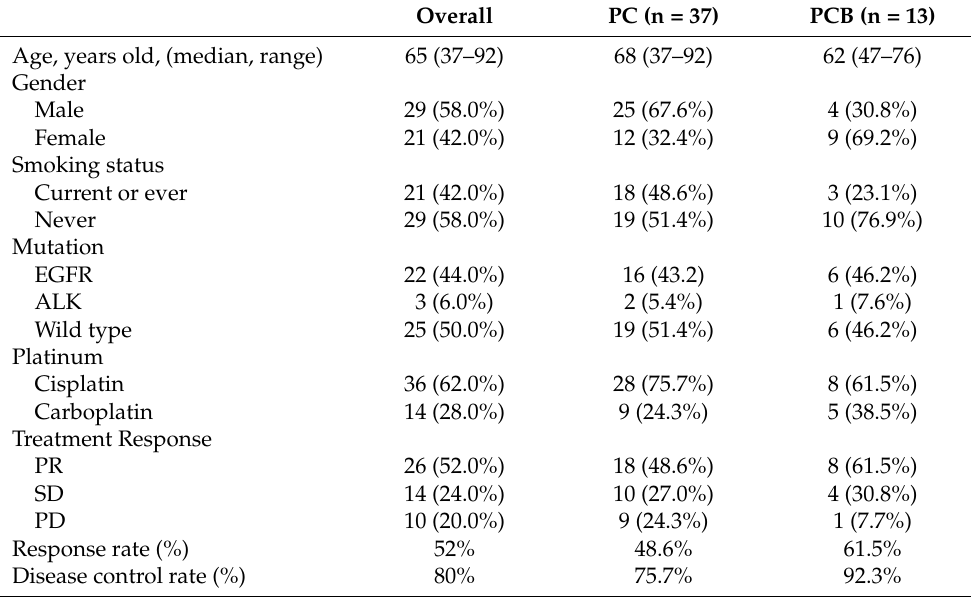
Table 1. Pemetrexed plus platinum with and without bevacizumab for NSCLC: Basic Characteristics and Treatment